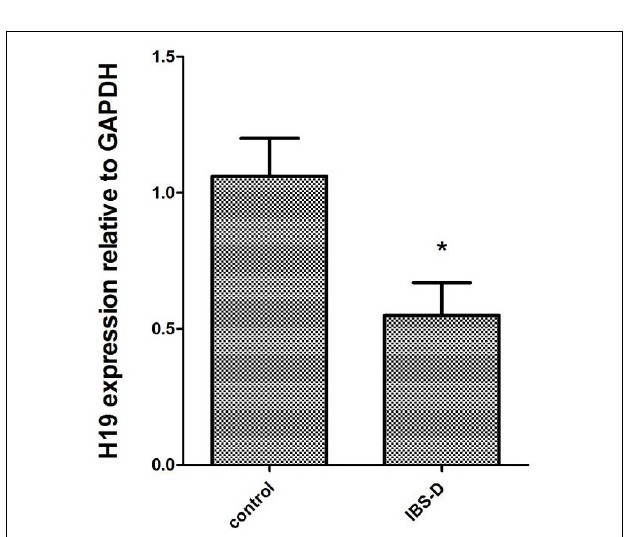
FIGURE 2 | H19 expression in the two groups of subjects by qRT-PCR. The expression of LncRNA H19 in patients with IBS-D and health controls was detected using qRT-PCR based on biopsies. Correlations among the two groups were analyzed by SPSS23.0 software. * P < 0.05, vs. control.